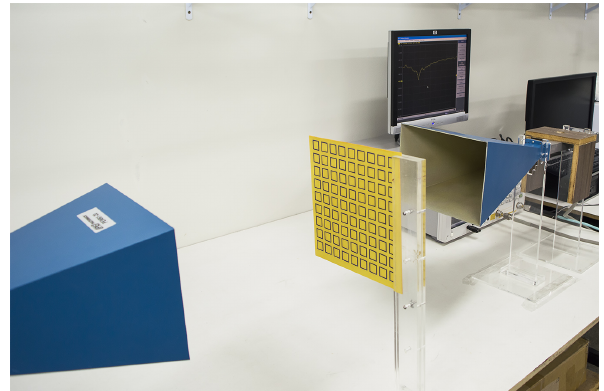
Figure 6: Setup used for the FSS transmission measure- ment.